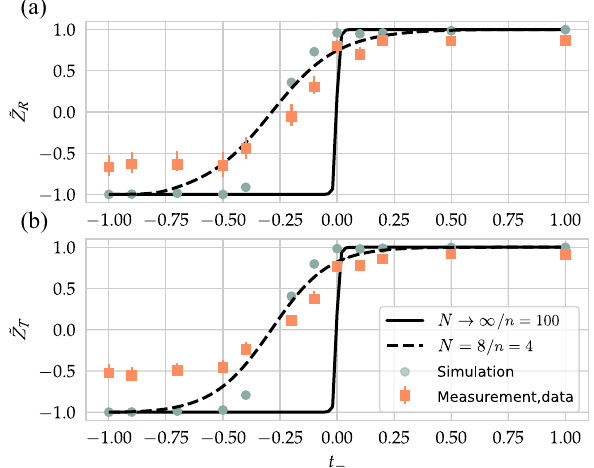
˜ Z FIG. 5. Many-body topological invariants R (spatial reflec- ˜ Z N ¼ 8 and n ¼ 4 in the ESSH tion) and T (time reversal) with model for δ ¼ 0 as a function of t − . For comparison, a simulation ˜ Z is included together with of the input parameters θ R=T for the opt ground states in the thermodynamic limit N → ∞ found by infinite-size density matrix renormalization group, and the finite system with N ¼ 8